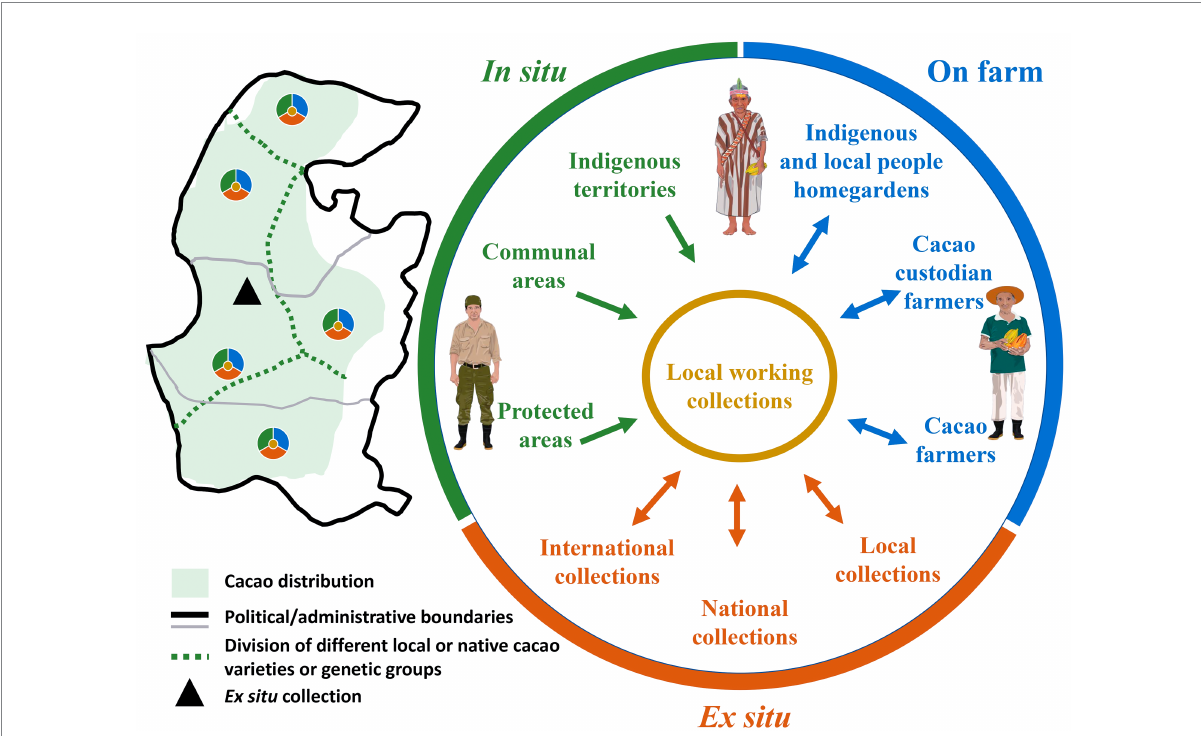
FIGURE 2 Detail of an integrated system of cacao conservation. The map on the left-hand side shows an imaginary cacao region in which several integrated conservation systems and one centralized ex situ collection have been set up across the cacao distribution range to preserve the diversity of local cacao varieties. The schematic representation on the right-hand side shows how working collections form the centerpiece of each of the regionally implemented integrated conservation system and link all the actors in the integrated system (blue for the on-farm actors, red for the ex situ , green for the in situ and yellow for the working collection). The different stakeholders exchange germplasm or vegetative material (arrows), thus strengthening their links and ensuring that local diversity is protected, but also widely